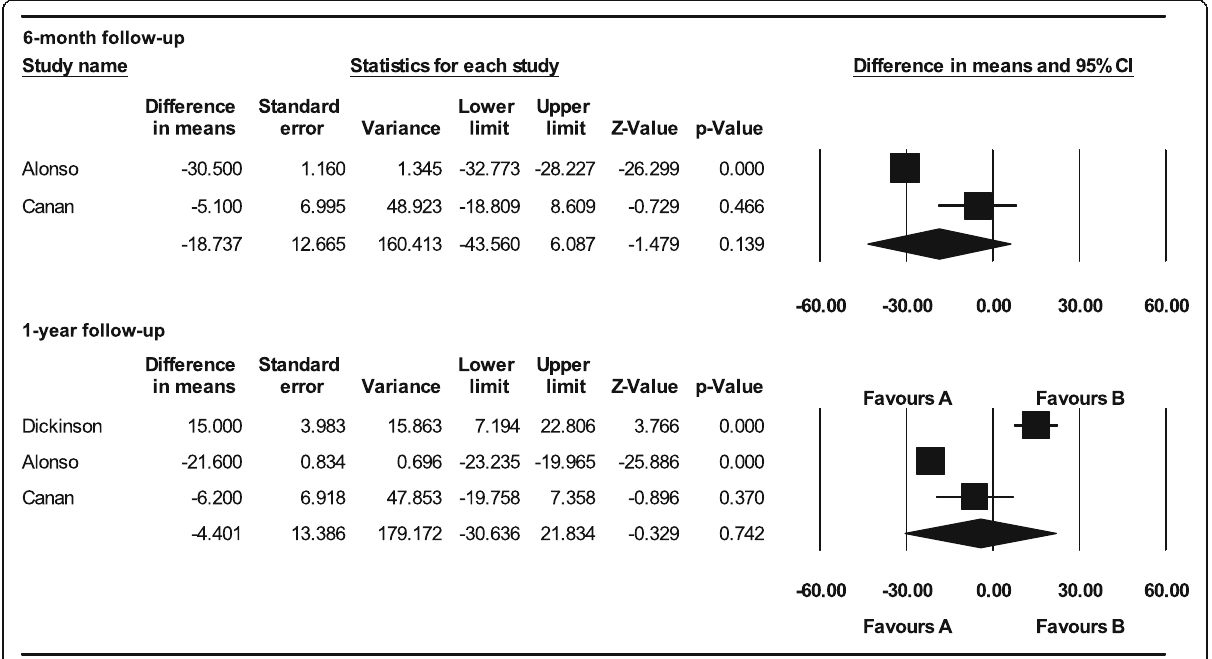
Fig. 5 Comparison of radiographic assessment between autologous bone and rh-BMP2 graft: bone graft height after 6-month and 1-year follow-up [favors A: autologous bone graft; favors B: alloplastic bone graft]